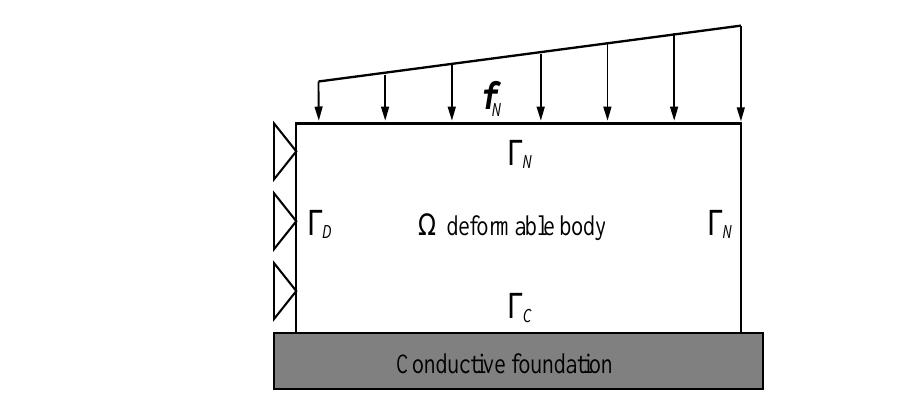
Figure 1. Physical setting.